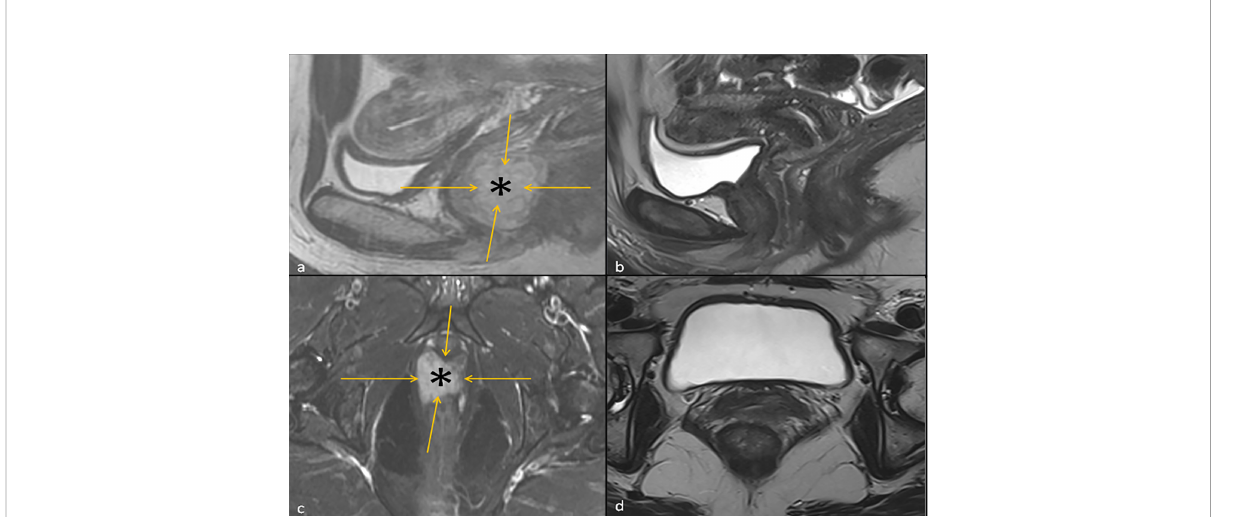
FIGURE 1 Left: T2 Sagittal Image (A) and fat suppressed T2 Axial Image (C) of the Pelvis at baseline showing a hyperintense vaginal mass (asterisk) outlined by orange arrows. Right: T2 Sagittal Image of the Pelvis (B) and Axial Image of the Pelvis (D) 3 months following the initiation ipilimumab and nivolumab neoadjuvant therapy, where the hyperintense vaginal mass is no longer